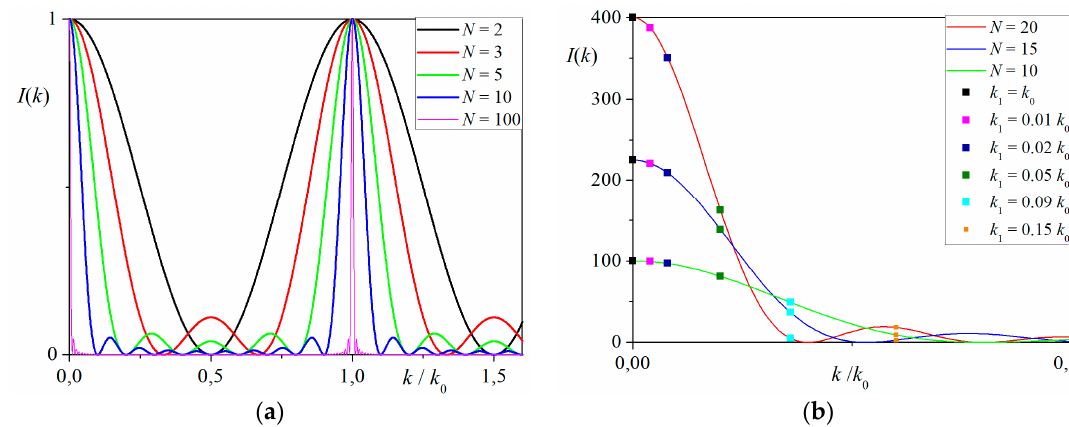
Figure 5. ( a ) The intensities of the multiple slit diffraction image calculated numerically for various number of scatterers ( N = { 2,3,5,10,100 } ). The peaks get narrower with increasing N . All peak heights are reduced to one. ( b ) Real picture of intensities calculated for three number of scatterers N = { 20,15,10 } . It is clearly seen that peak heights at k = 0 scale with N 2 , whereas the scaling of intensities taken for different k 1 (cid:54) = k 0 (marked with different colors) is different. For both figures k 0 = 2 π (in arbitrary units).